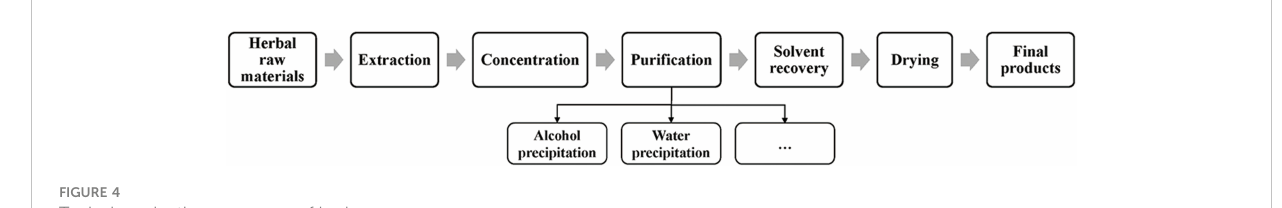
FIGURE 4 Typical production processes of